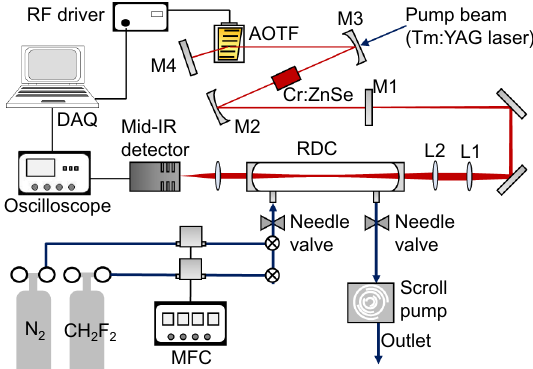
Figure 1. Schematic of the experimental setup. AOTF acousto-optic tunable filter, M1 output coupler, M2 and M3 folding mirrors, M4 total reflector, L1 and L2 lens pair, RDC ring-down cavity, MFC mass flow controller. The footprint of the ET-Cr:ZnSe laser and CRDS setup was 90 cm × 60